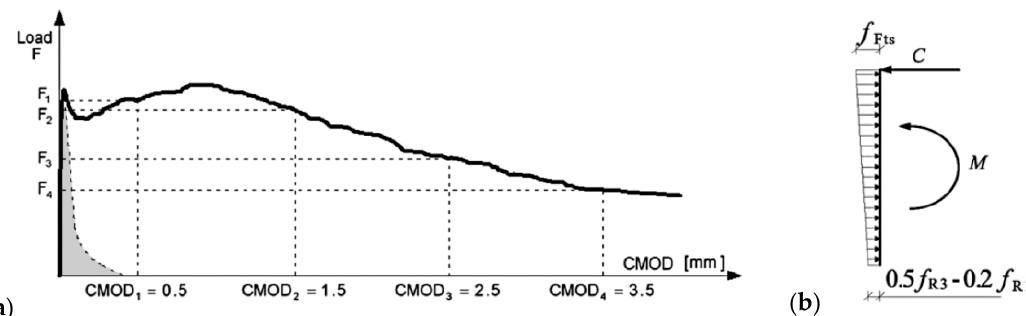
Figure 7. ( a ) Typical load vs. CMOD curve for plain concrete (in grey) and fiber-reinforced concrete (FRC) (in black) and ( b ) Stress distributions assumed for FRC in the fib Model [37].